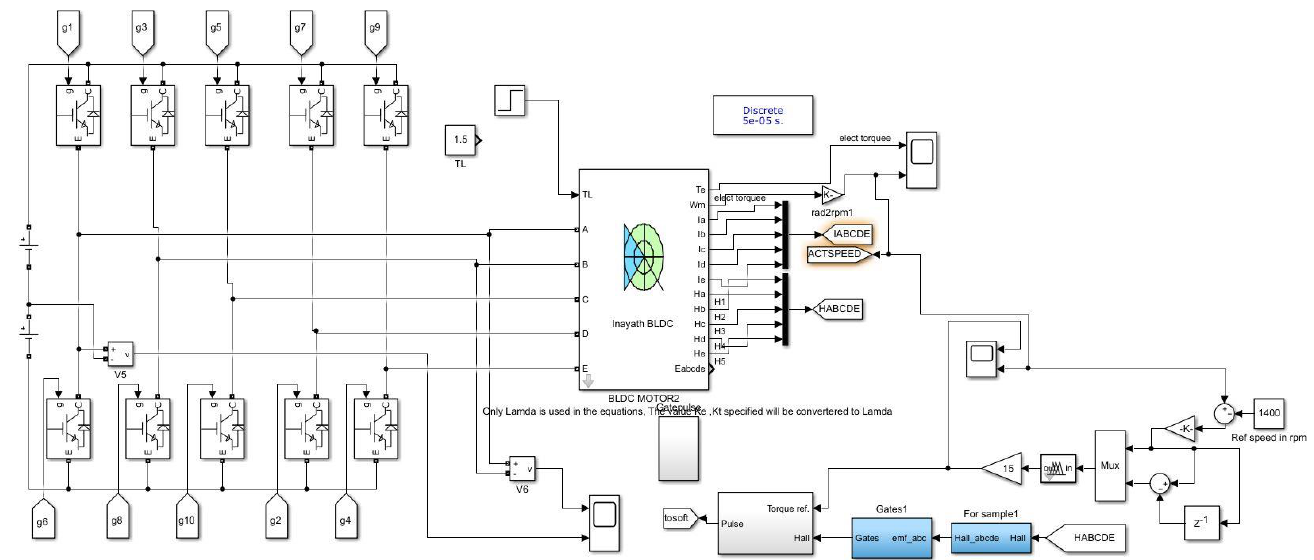
Figure 5. ANFIS speed controller of five-phase PMBLDC drive- Simulink layout.